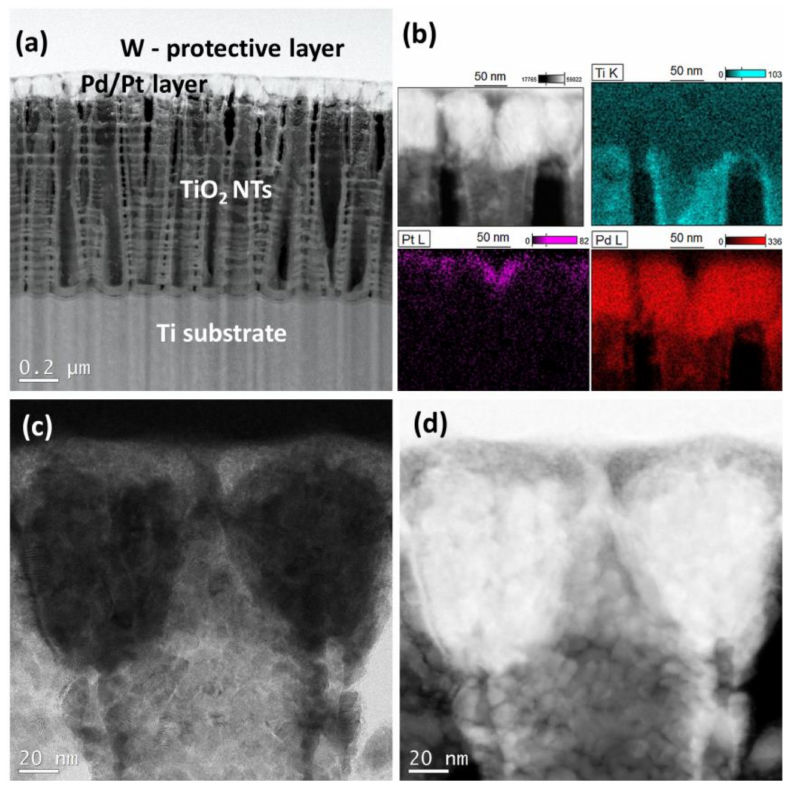
Figure 4. Cross-sectional view of titania nanotubes (25 V) adorned with Pd / Pt (magnetron sputtering technique) ( a ) HAADF-STEM image with visible layers, ( b ) EDS elemental maps indicating presence